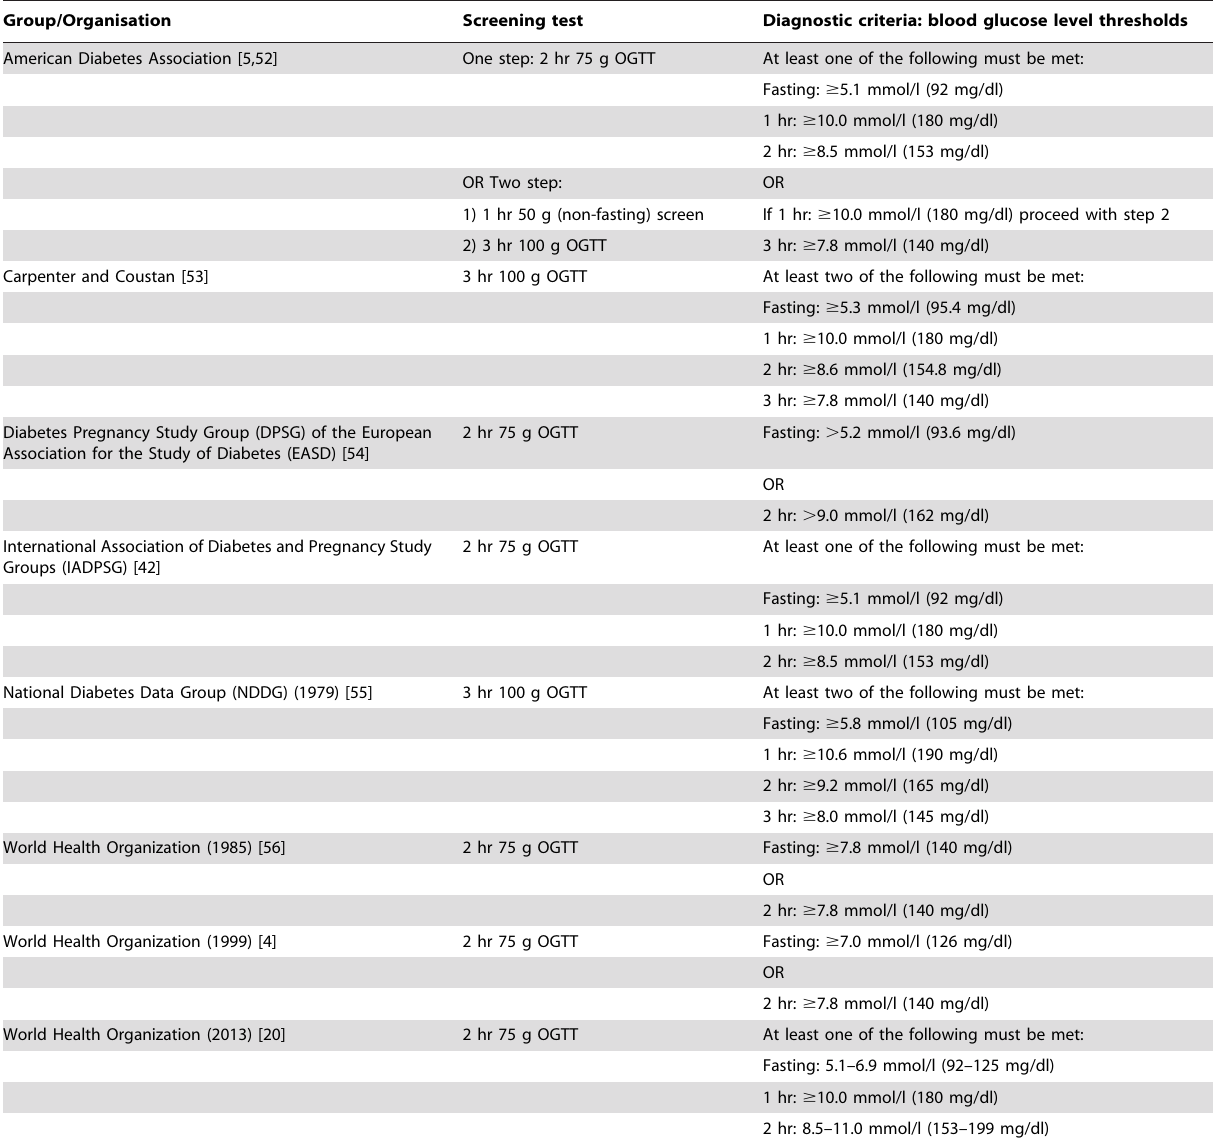
Table 1. The different diagnostic criteria available for the diagnosis of gestational diabetes mellitus.